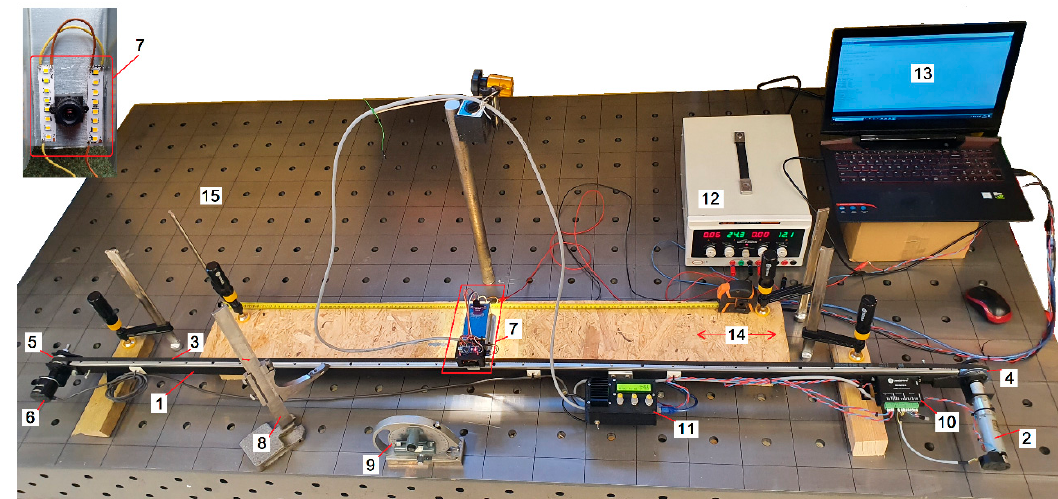
Figure 2. Built test stand for sensors linear displacement measurements.